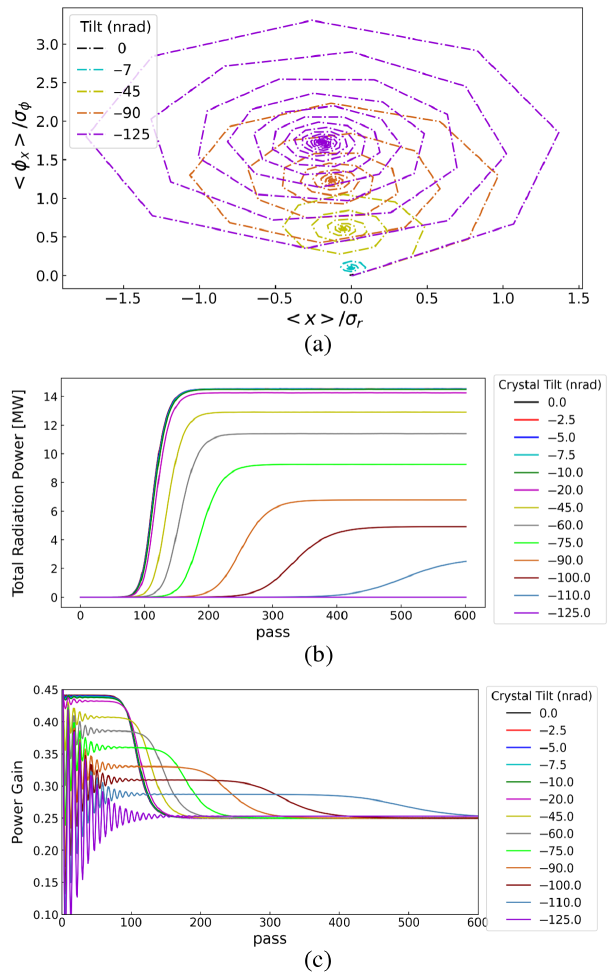
FIG. 5. Evolution of (a) transverse centroid phase space of the radiation beam at the waist along the misalignment dimension, (b) total radiation power, and (c) radiation power gain per pass for constant crystal tilts from 0 to 125 nrad in the first crystal of XFELO-A defined by Table I and Fig. 4(a).